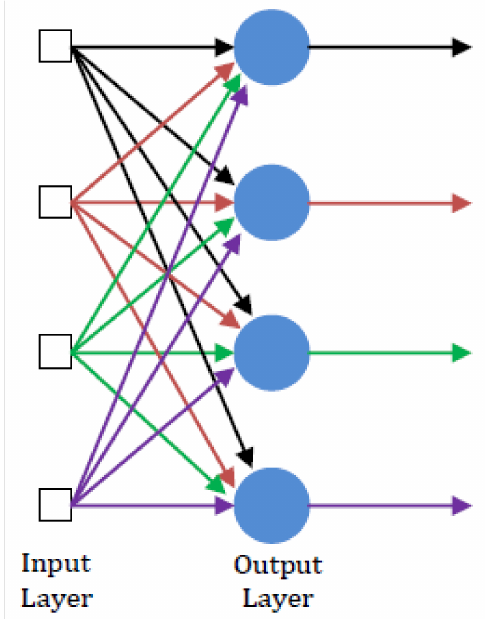
Figure 4. The single—layer feedforward